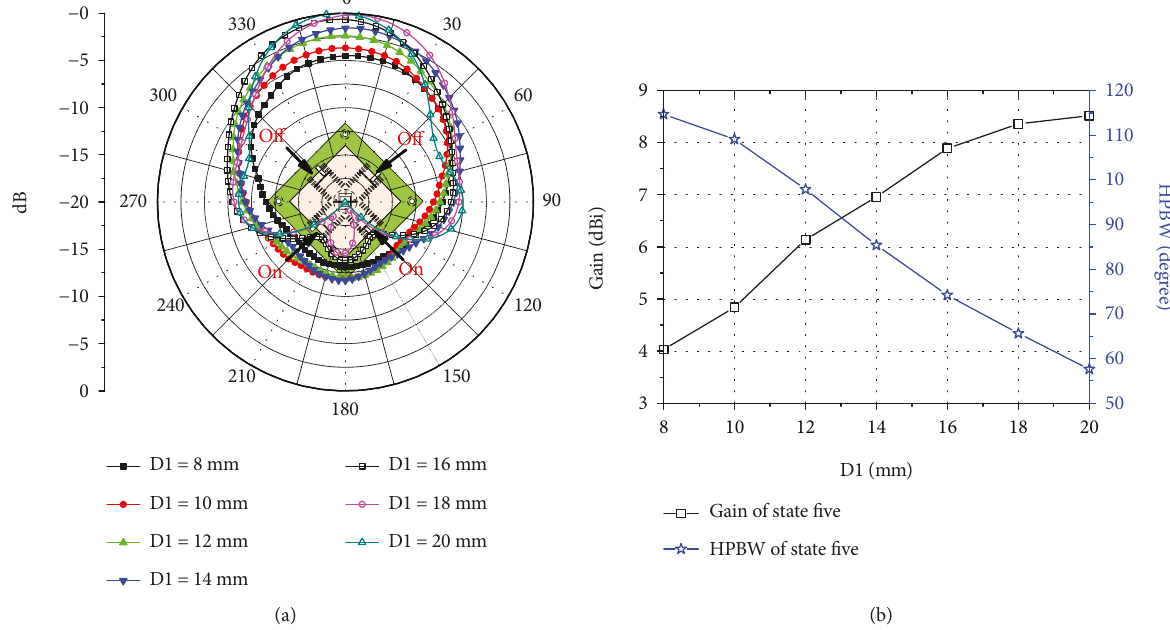
Figure 3: (a) Patterns of di ff erent distance state V with di ff erent distance of D1 measured at 5.2GHz. (b) Gain and HPBW of state V with di ff erent distance of D1 measured at 5.2 GHz. Table 1: Di ff erent con fi guration states of the proposed